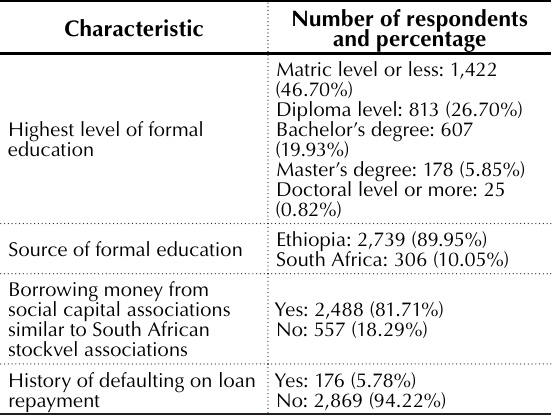
Table 3. Level of education and access to finance